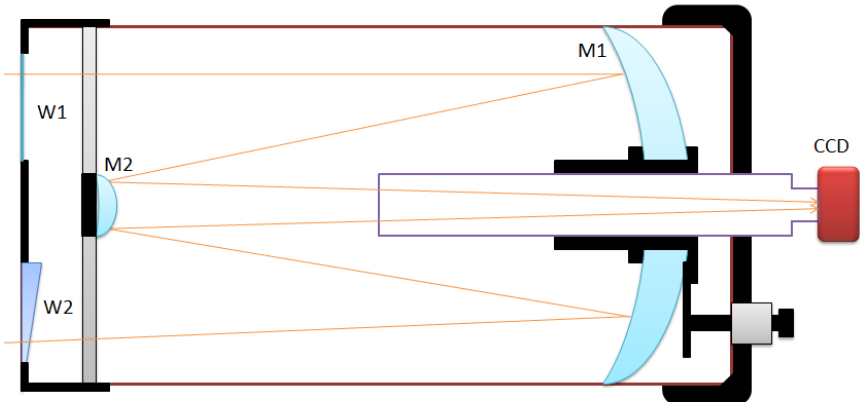
Figure 1. Optical scheme of the DIMM. M 1 -main optical mirror, M 2 -secondary hyperbolic mirror, W 1 -first slit, W 2 -second prismatic slit.